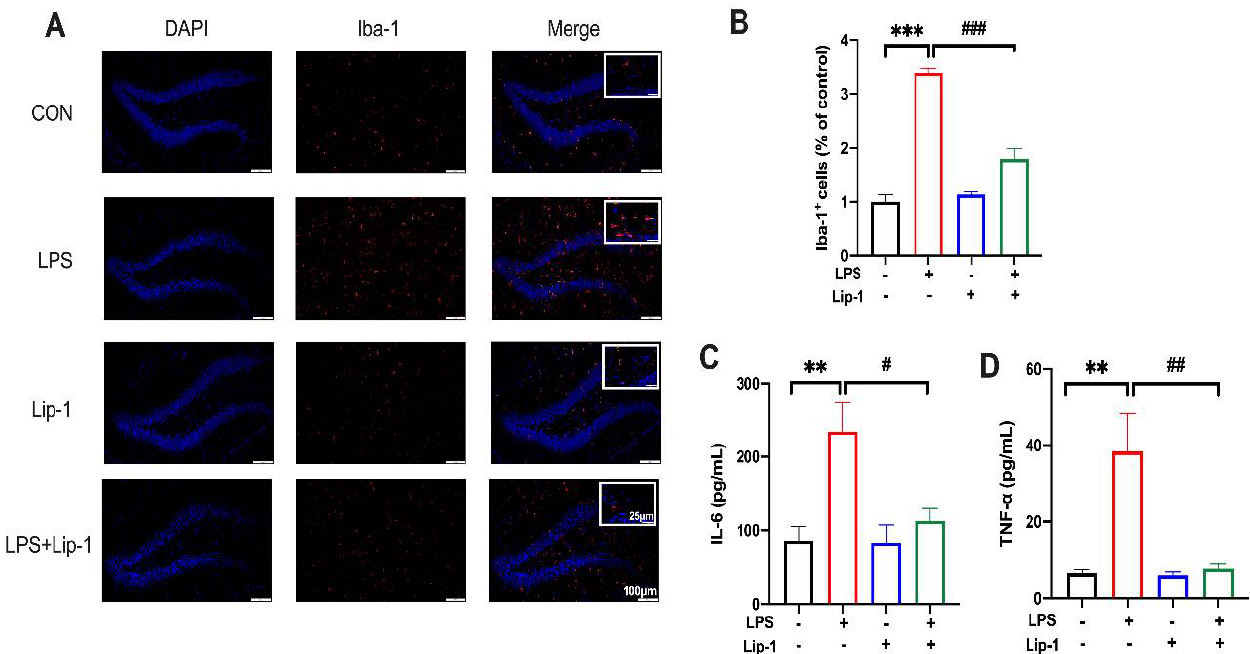
Figure 4. Liproxstatin-1 alleviated LPS-induced microglial activation and inflammatory cytokine accumulation. ( A ) Representative images of Iba-1 labeled activated microglia in the hippocampal DG region (scale bar = 100 µ m) and magnified views (scale bar = 25 µ m). ( B ) The numbers of Iba-1 + cells in the hippocampal DG region ( n = 4). ( C , D ) Levels of IL-6 and TNF- α in the hippocampus ( n = 5). Data are expressed as mean ± SE. ** p < 0.01, *** p < 0.001 vs. CON group; # p < 0.05, ## p < 0.01, ### p < 0.001 vs. LPS group.